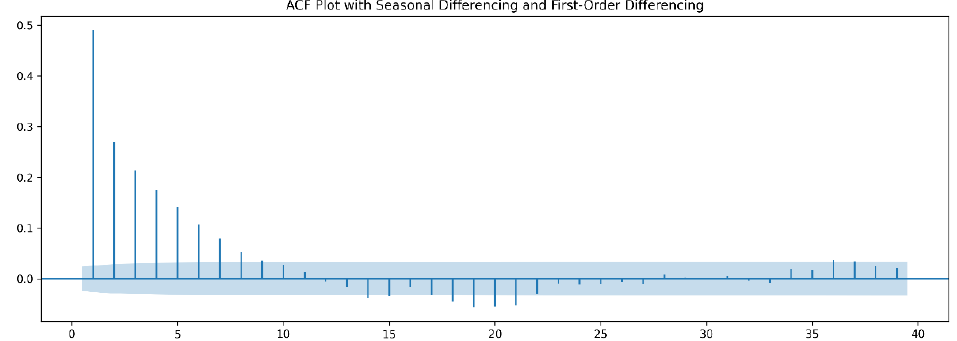
Figure 7. Autocorrelation Plot of the Historical Water Levels after applying seasonal differencing with l = 365 and first-order differencing. First-order differencing is applied when fitting the ARIMA model with d = 1.